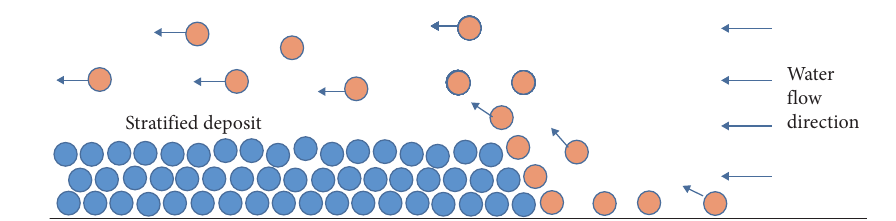
Figure 1: Schematic of the incipient motion of cement